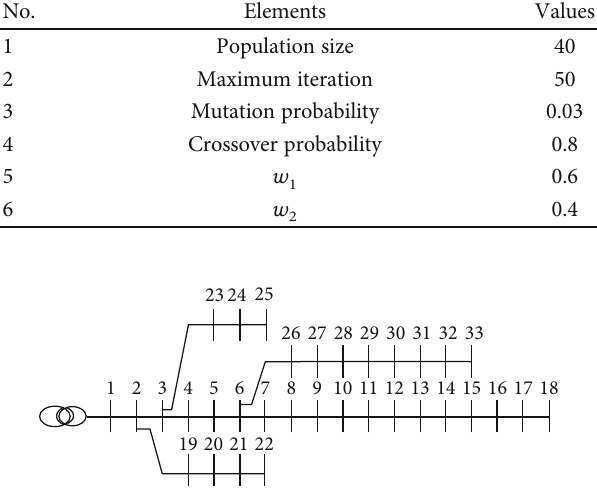
Figure 2: Map of the IEEE-33 bus radial distribution